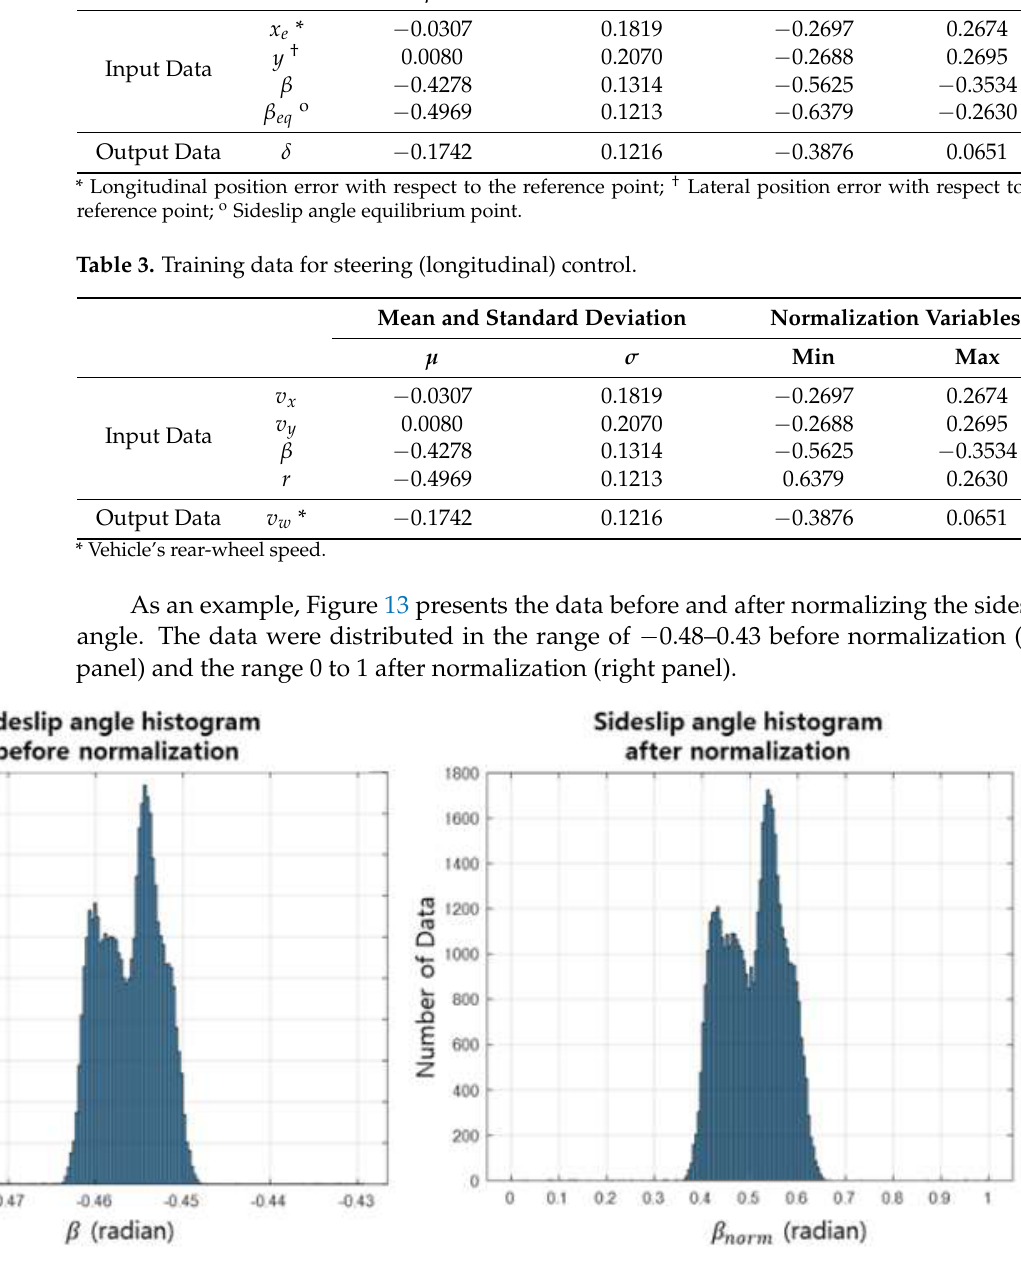
Figure 13. Results of preprocessing the training data of sideslip angle.